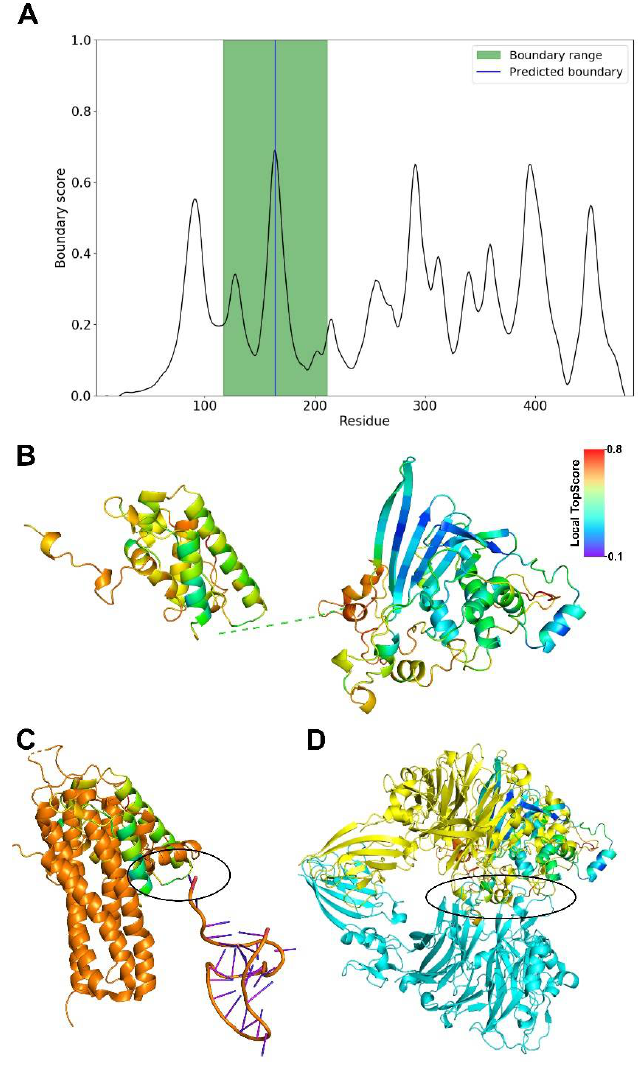
Figure 3. Molecular model of SFV-chimpanzee Bet protein domains. ( A ) Domain boundaries predicted by TopDomain [222]. The blue line indicates the split of the sequence into two domains (between residues 164 and 165), which were subsequently modeled separately. ( B ) Domains are shown in cartoon representation. The coloring indicates the quality assessment of the models on a per-residue level by TopScore [223]. Blue: TopScore = 0.1 (high structural quality), red: TopScore = 0.8 (low structural quality). The dotted line represents the connection between domain 1 (left, residues 1–164) and domain 2 (right, residues 165–490). Structural models were generated with ROBETTA [217]. The mutual spatial arrangement of both domains is unknown. ( C ) Overlay of the C-terminal domain and PDB ID 5M0I_C. The interaction region with mRNA is marked in black. The C-terminal domain is colored as in panel B, 5M0I is colored in orange. ( D ) Overlay of the N-terminal domain and PDB ID 6PQ8_A. The interaction region with chain B of 6PQ8 is marked in black. The C-terminal domain is colored as in panel B, 6PQ8 chain A is colored in yellow, 6PQ8 chain B is colored in blue. 3.4, identity = 3%, RMSD = 4.5 Å), but the overlaying part consists of transmembrane helices. The second best hit (6IKN_A) is also a membrane protein, which we deem inapt